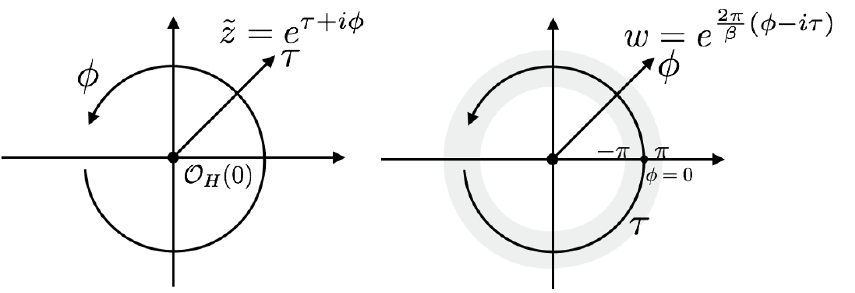
Figure 7 . We move to the uniformizing coordinate w by the conformal transformation where the e(cid:11)ect of the insertions of the heavy operators O H is replaced by the background geometry. The Euclidean plane (~ z; (cid:22)~ z ) is mapped to the gray region in the w coordinate; (cid:30) r and (cid:30) r + 4 (cid:25) 2 =(cid:12) are same point in the ~ z coordinate. It expresses the monodromy around the black hole